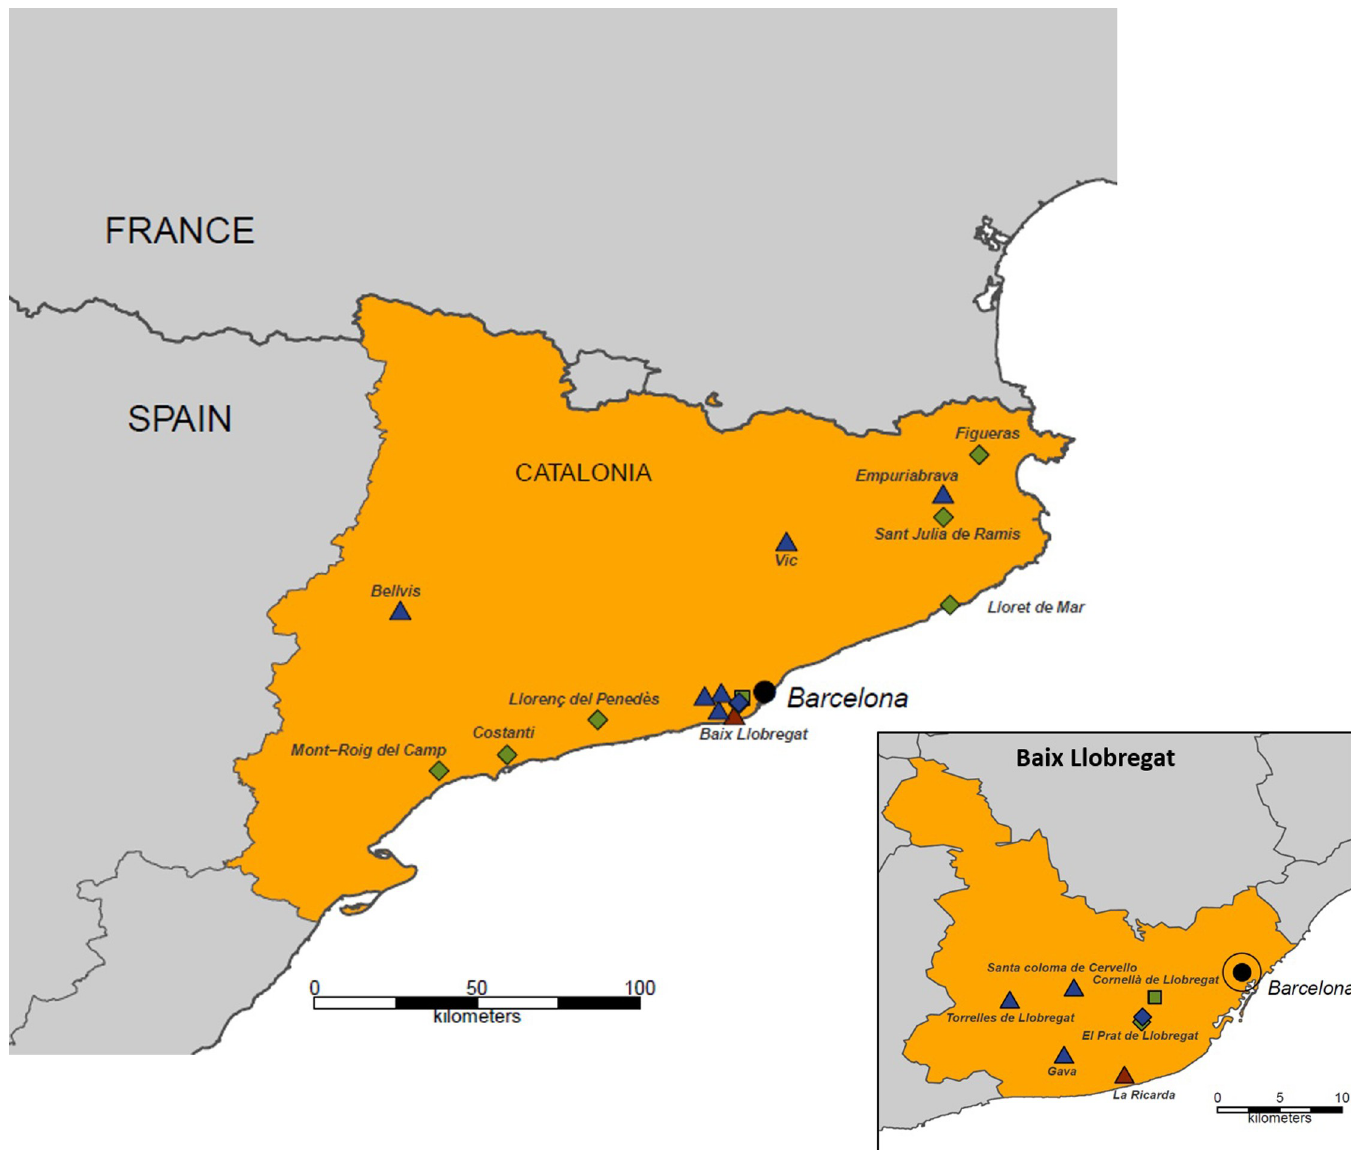
Fig 1. Map of Catalonia (Spain) highlighting the areas where Aedes albopictus (green symbols; 2012–2014, 2016), Culex pipiens (blue symbols; 2012–2014, 2015, 2016, 2017) and Aedes caspius (red symbol; 2017) were collected for the insecticide susceptibility assays. Diamonds indicate mosquitoes collected as eggs, triangles show sites with immature collections, and squares indicate adult